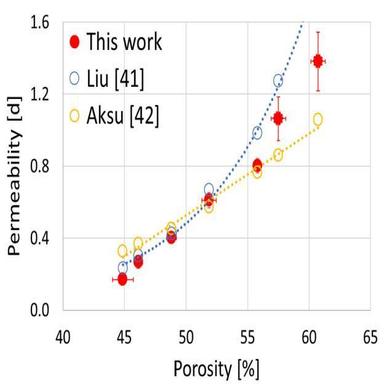
Comparison of the calculated data with relationships from the literature.